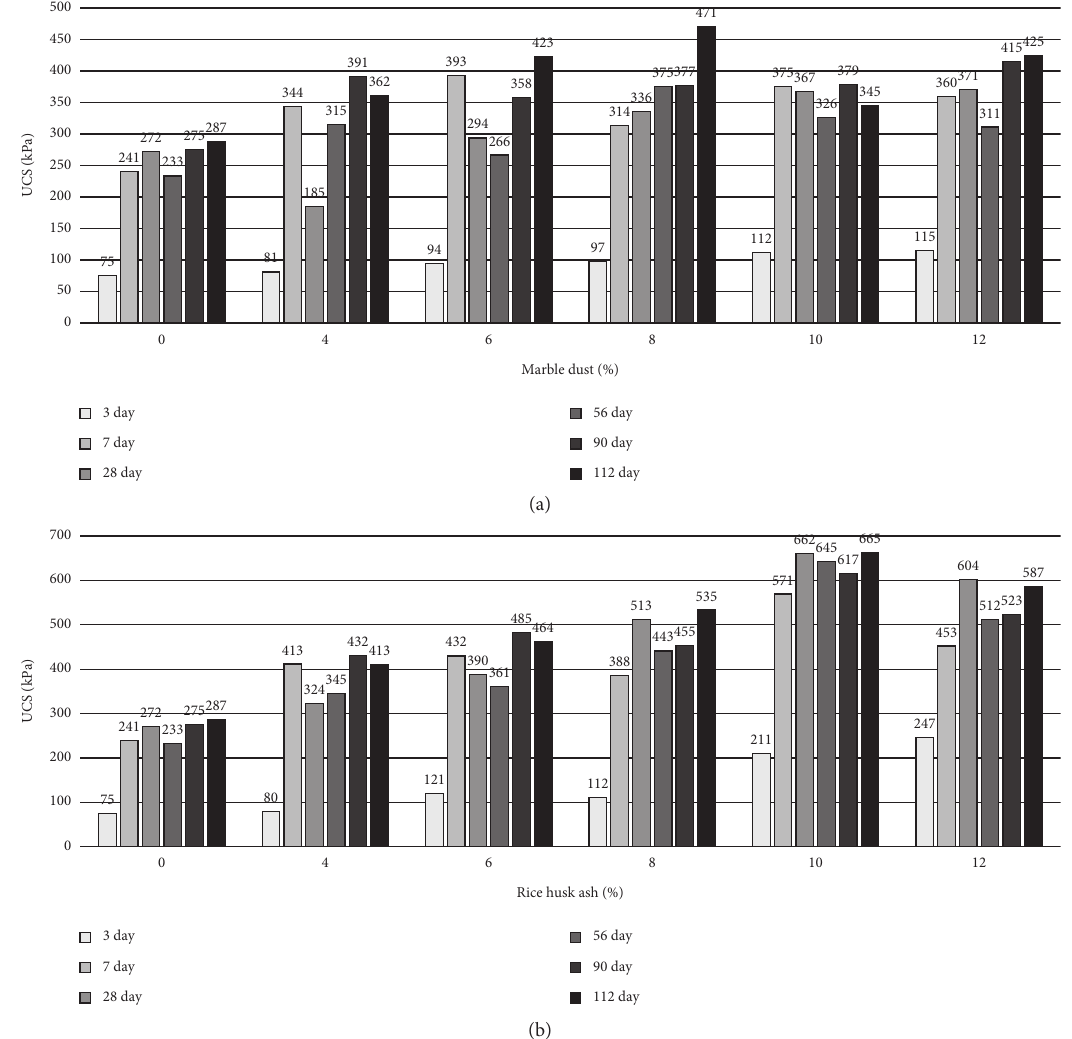
Figure 7: (a, b) Unconfined compression strength at 3, 7, 28, 56, 90, and 112 days with marble dust/rice husk